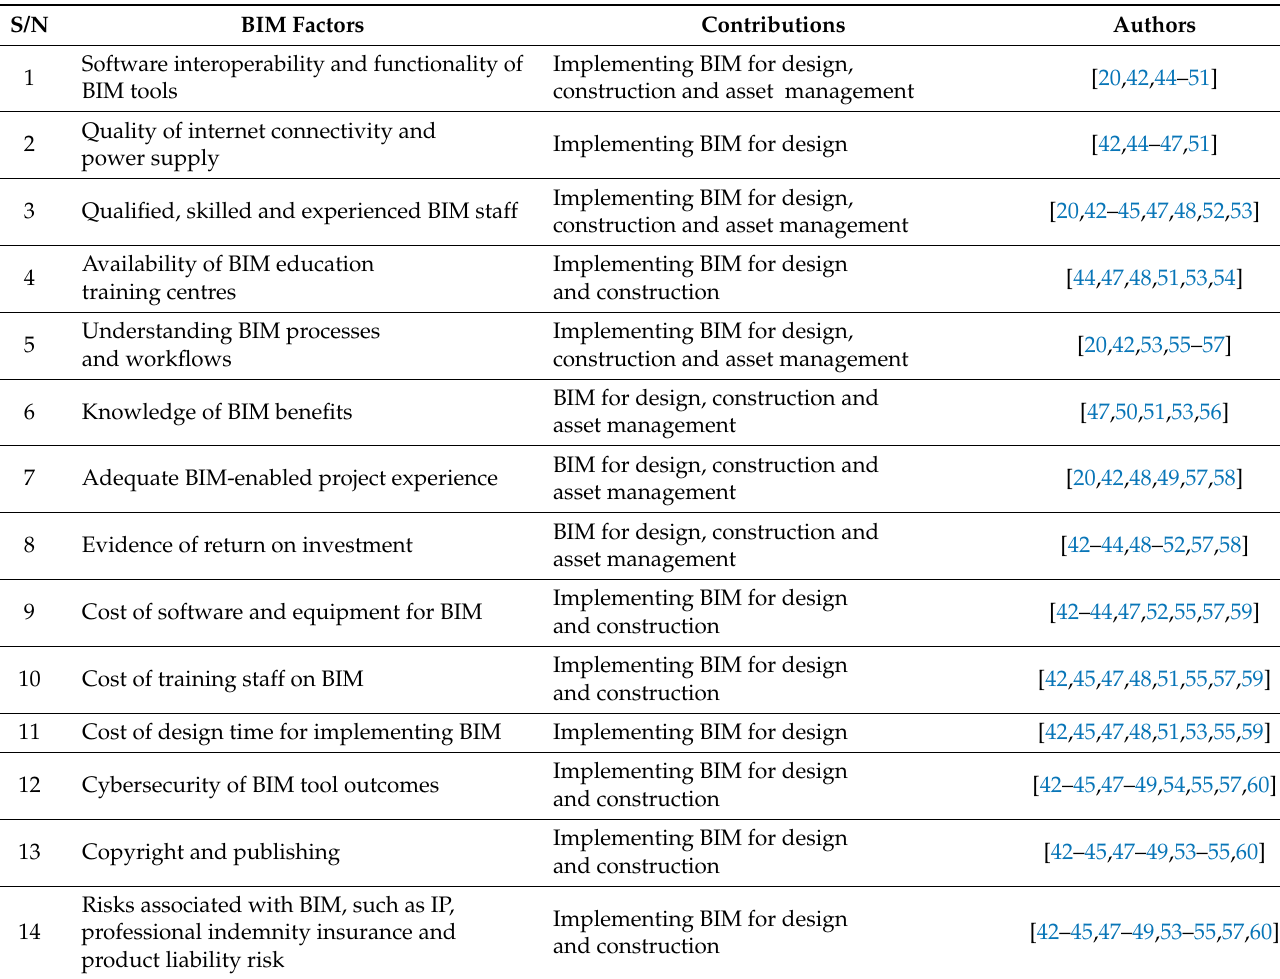
Table 2. BIM implementation